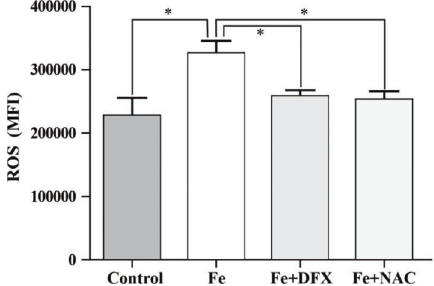
Figure 3. Labile iron pool (LIP) levels of Lin-Sca-1 + c-kit (LSK) + in iron overload mice (Fe) signi fi cantly increased compared to the control group and were reversed by the administration of deferasirox (DFX) or N-acetyl-L-cysteine (NAC) in mean fl uores- cence intensity (MFI). Data are reported as means ± SD. ***P o 0.001, ANOVA.